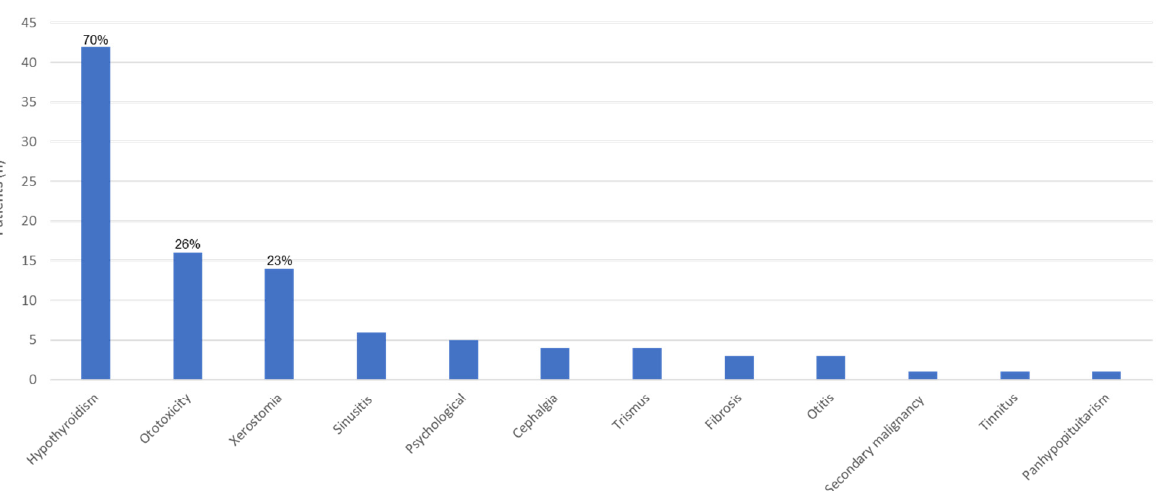
median follow-up of 40 months. a